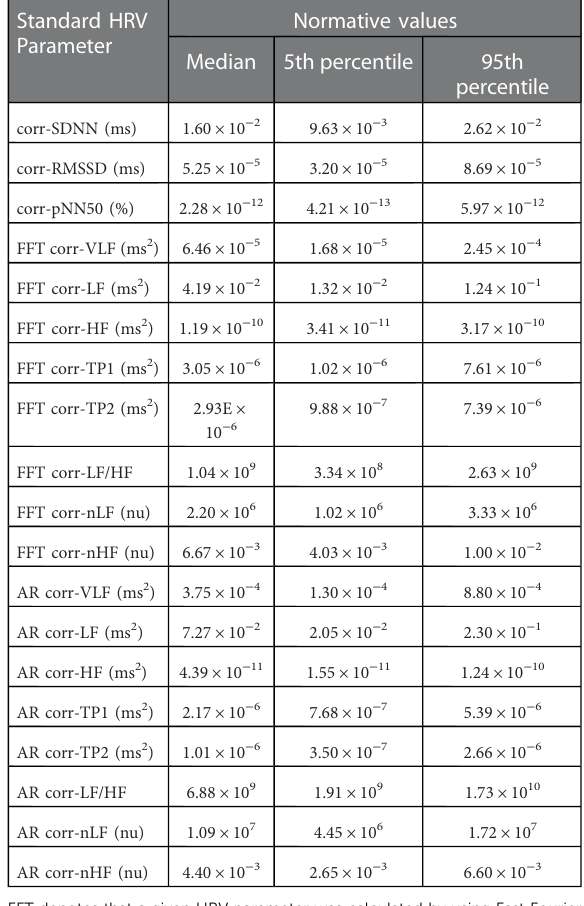
TABLE 6 Normative values for corrected HRV parameters for the whole study group. Standard HRV